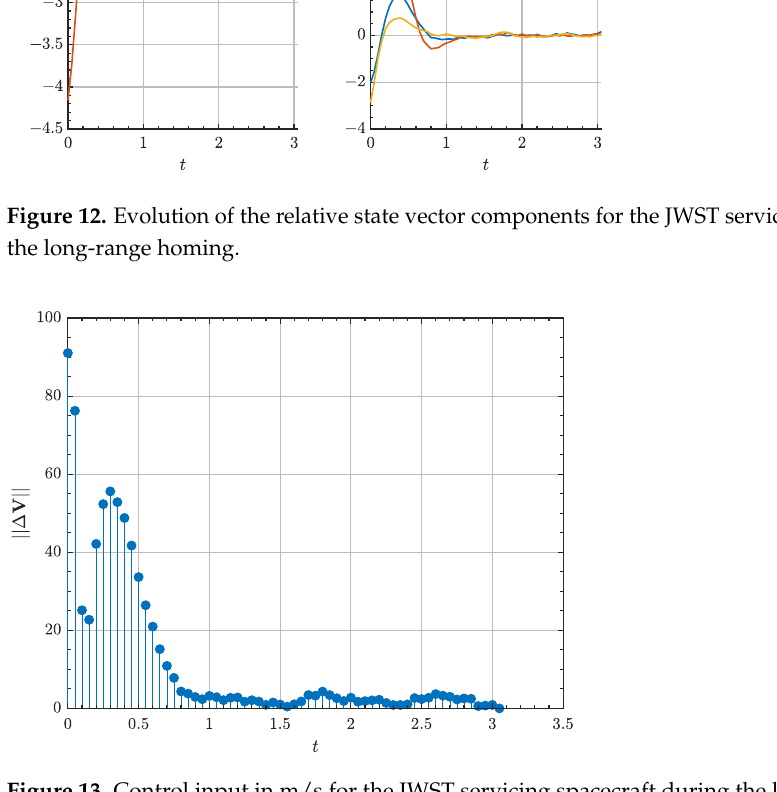
Figure 13. Control input in m/s for the JWST servicing spacecraft during the long-range